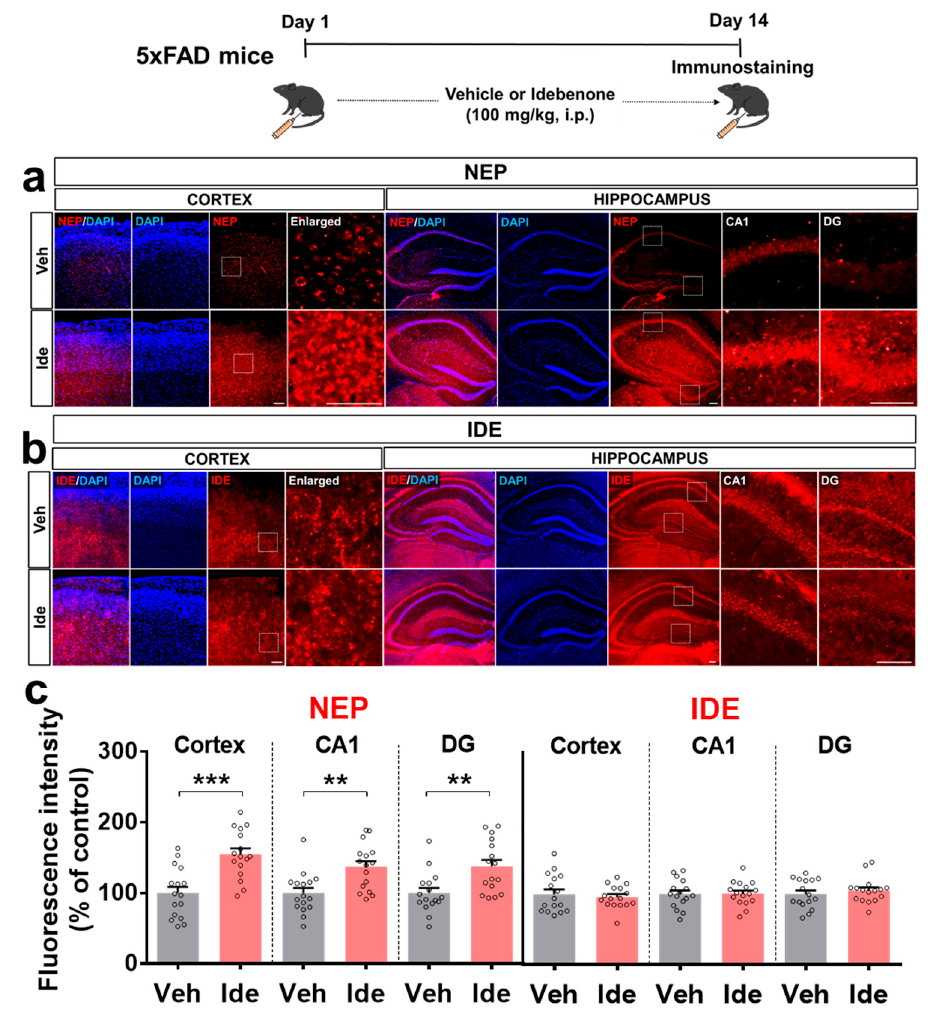
Figure 4. Idebenone significantly upregulates NEP levels in a mouse model of AD. ( a , b ) Representa- tive images of cortical and hippocampal NEP and IDE immunofluorescent staining. Idebenone or vehicle was administered daily to 3-month-old mice for 14 consecutive days, as shown at the top of the figure. Immunostaining of brain sections was then performed with anti-NEP and anti-IDE. ( c ) Quantification of the results (n = 16 brain slices from four mice/group). ** p < 0.01 and *** p < 0.001 vs. vehicle-treated control. Scale bar = 100 µm for cortex and 200 µm for hippocampus.